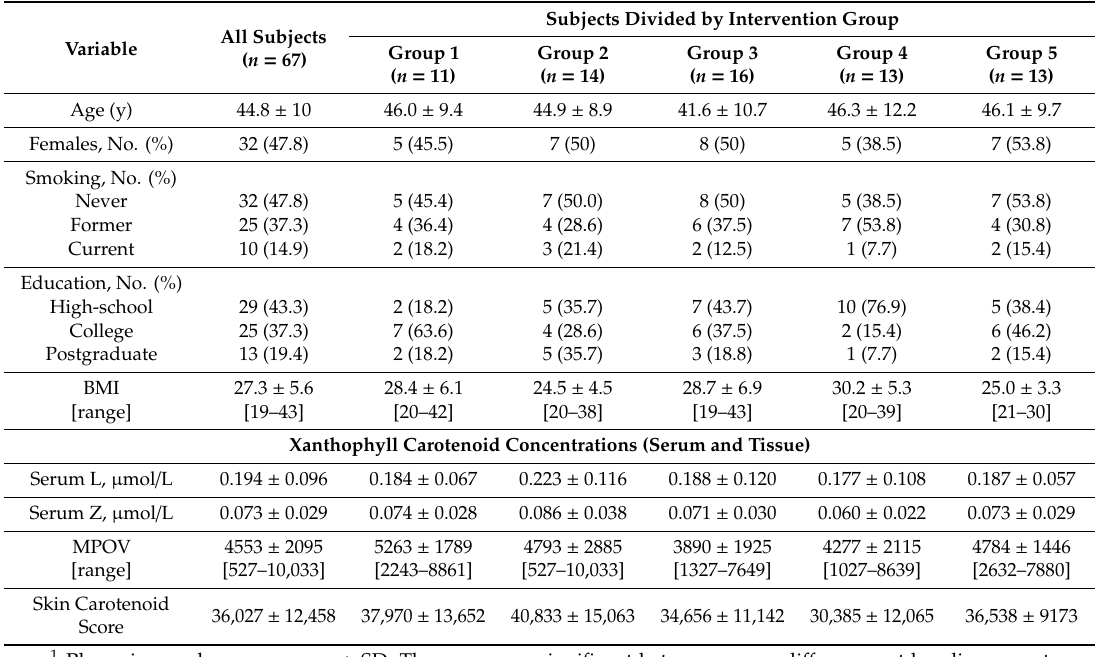
Table 1. Baseline characteristics of the study participants 1